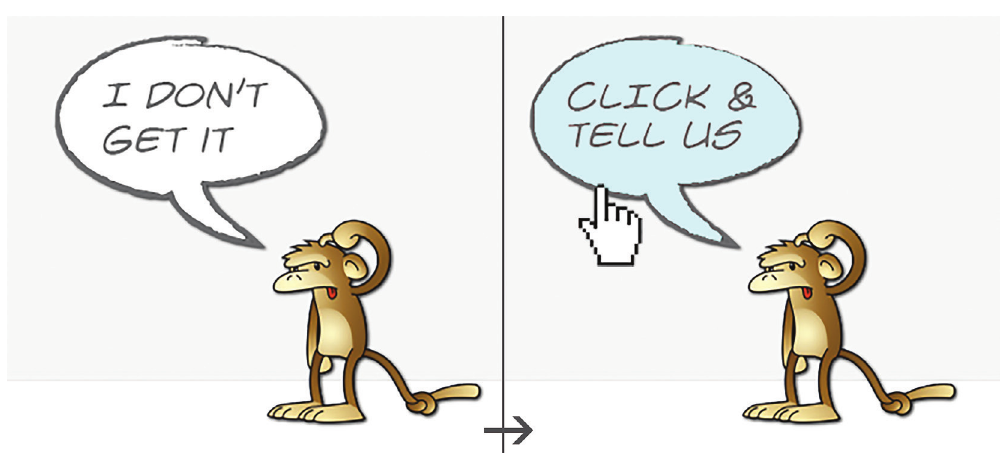
Figure 1: The ‘I don’t get it’ button for user